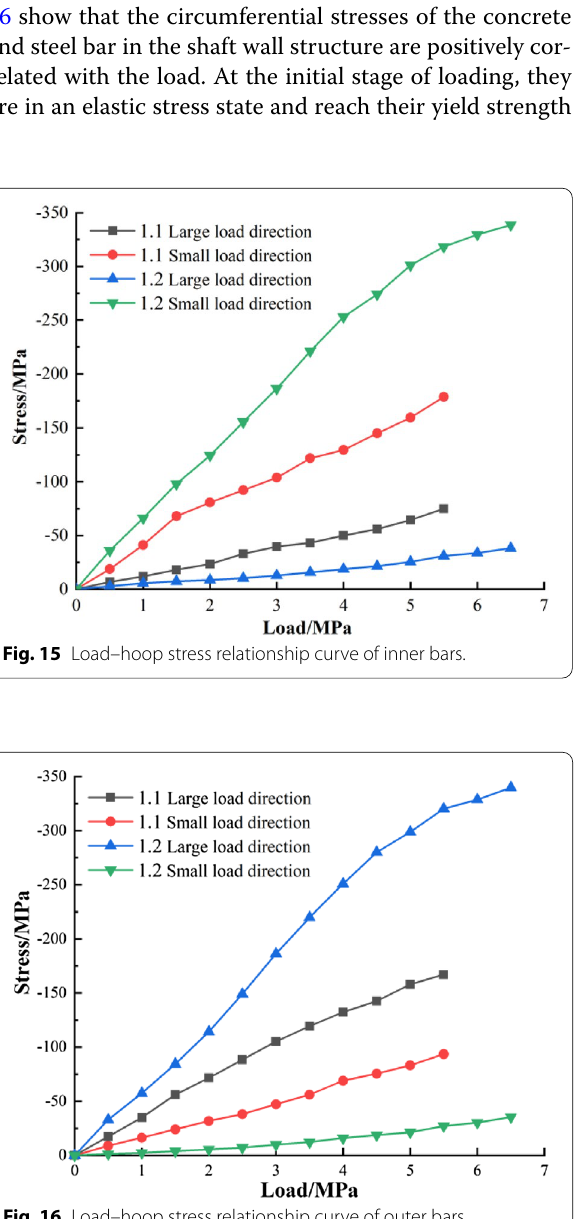
Fig. 14 Concrete load–hoop stress relationship curve of inner edge.